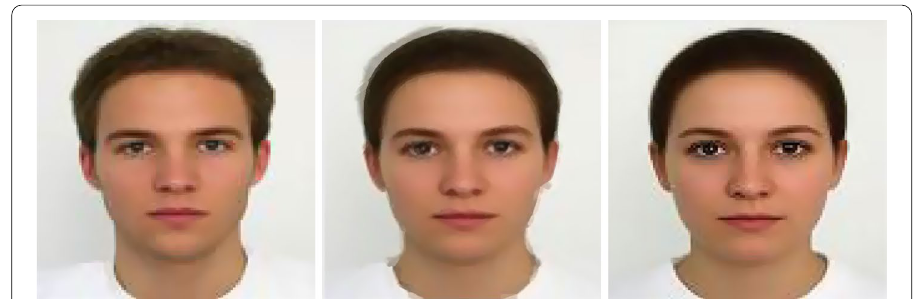
Fig. 1 Face morphing. left: source face image. middle: morphed face. right: target face